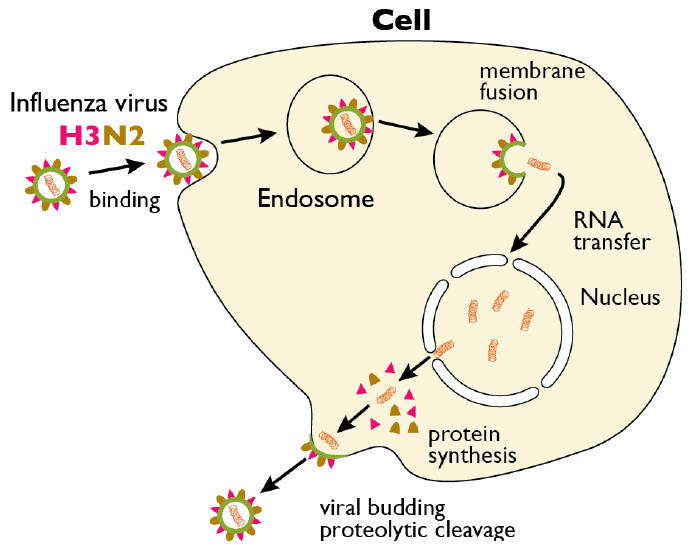
Figure 1. The replication cycle of influenza virus. Influenza virus binds to sialic acid groups present in the glycocalyx of the plasma membrane (glycocalyx omitted for clarity). The bound virus is subsequently endocytosed. Hemagglutinin (HA) is color-coded in red; Neuraminidase is color-coded brown. Ion channels and lipids are color-coded green. During maturation of the endosome, the pH drops, initiating the fusion of the viral envelope (green) with the endosomal membrane (gray) and the release of the viral RNA (orange) and viral proteins into the cytosol. The viral RNA traffics to the nucleus, where replication takes place. Newly formed viral RNAs are exported to the cytosol where they assemble with new virus structural proteins, which are packaged together at the plasma membrane, and bud off to form new